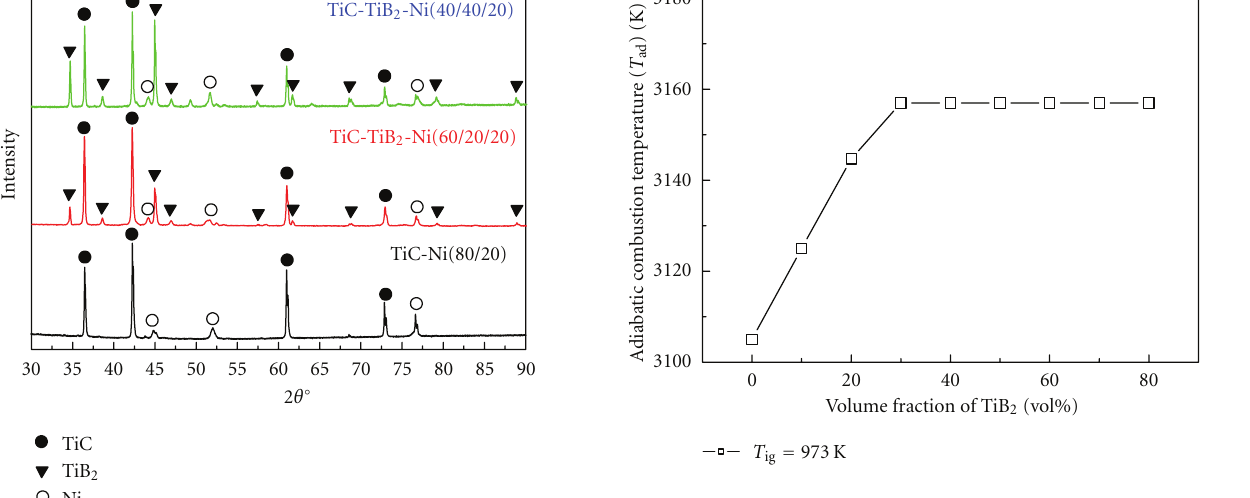
Figure 4: Relationship between T ad and TiB 2 volume fraction of samples with 20vol%